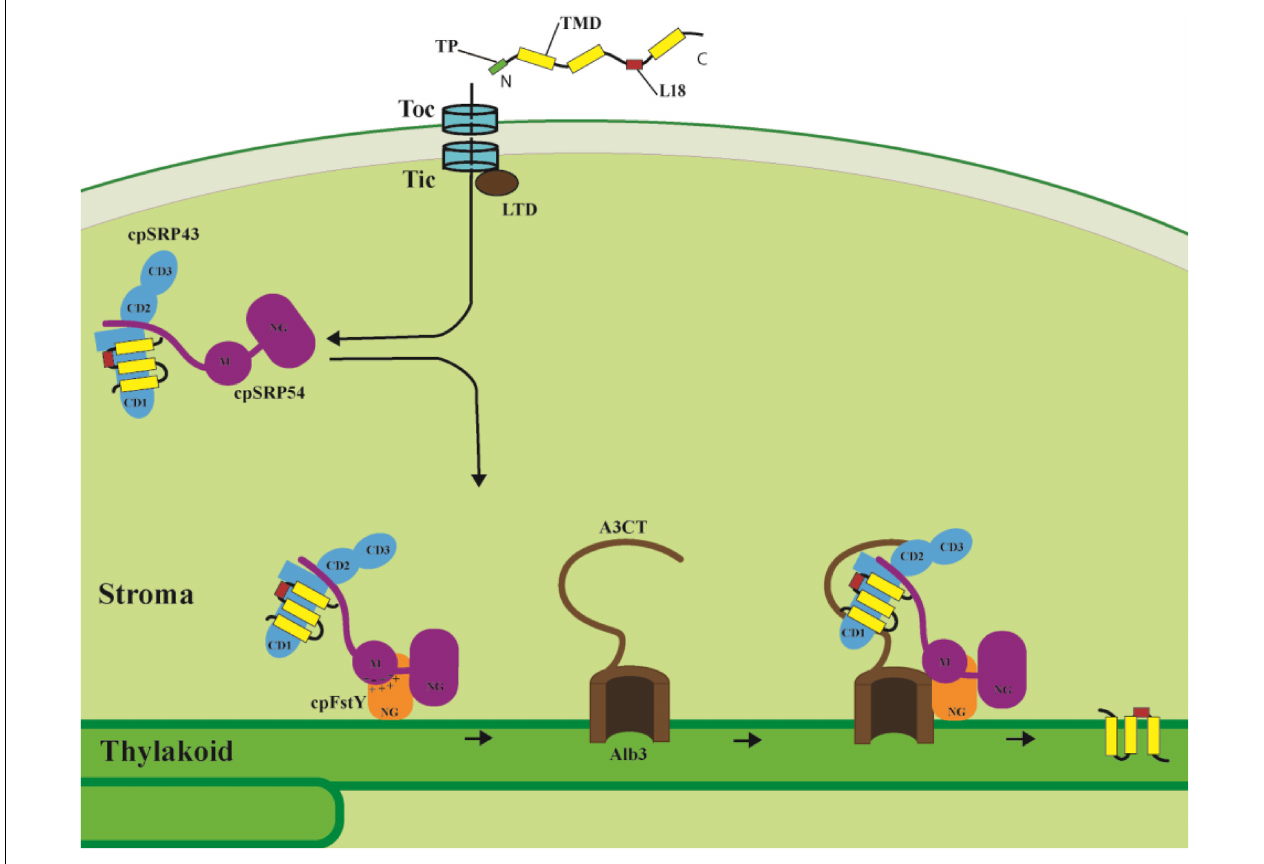
FIGURE 2 | LHCPs targeting into thylakoid membranes through the cpSRP pathway. After import into the stroma through the Toc/Tic system, the LHCPs are transferred to the cpSRP43/cpSRP54 complex with the help of LTD. The L18 region between the second and third TMD of LHCP is the binding site for cpSRP43. Then cpSRP54 interacts with cpFtsY through their homologous NG domains, while the negatively charged cluster of cpSRP54 M domain interacts with the positively charged cluster of cpFtsY G domain and enhances the cpSRP54/cpFtsY complex assembly. Finally, Alb3 C-terminal tail (A3CT) interacts with the C-terminal chromodomains CD2 and CD3 of cpSRP43, and thus facilitates LHCP delivery to the Alb3 translocase and insertion into the thylakoid membrane. TP, transit peptide. TMD, transmembrane